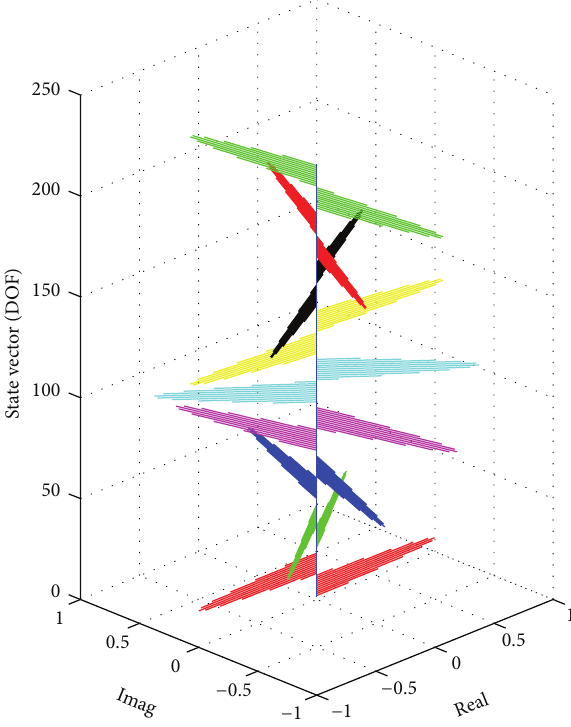
Figure 1: Eighth order, pole-weighted vector (state vector)